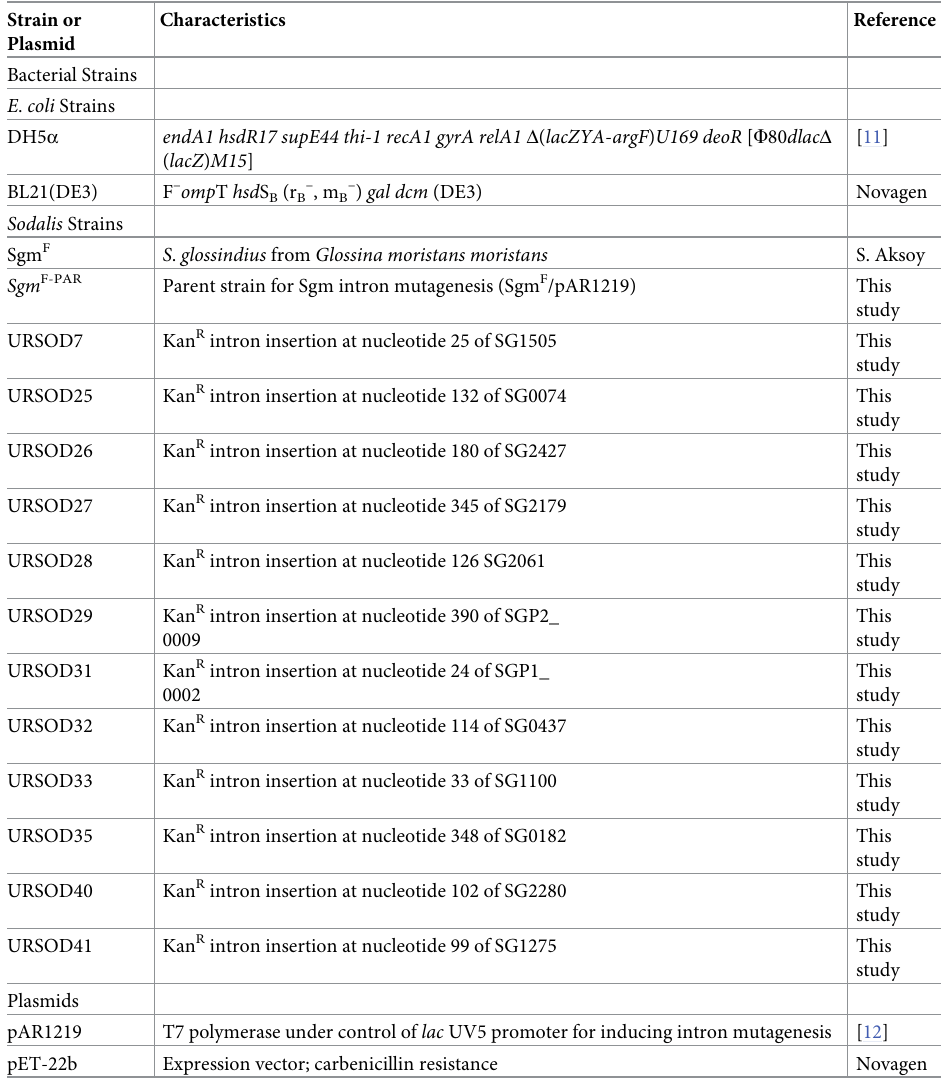
Table 1. Bacterial strains and